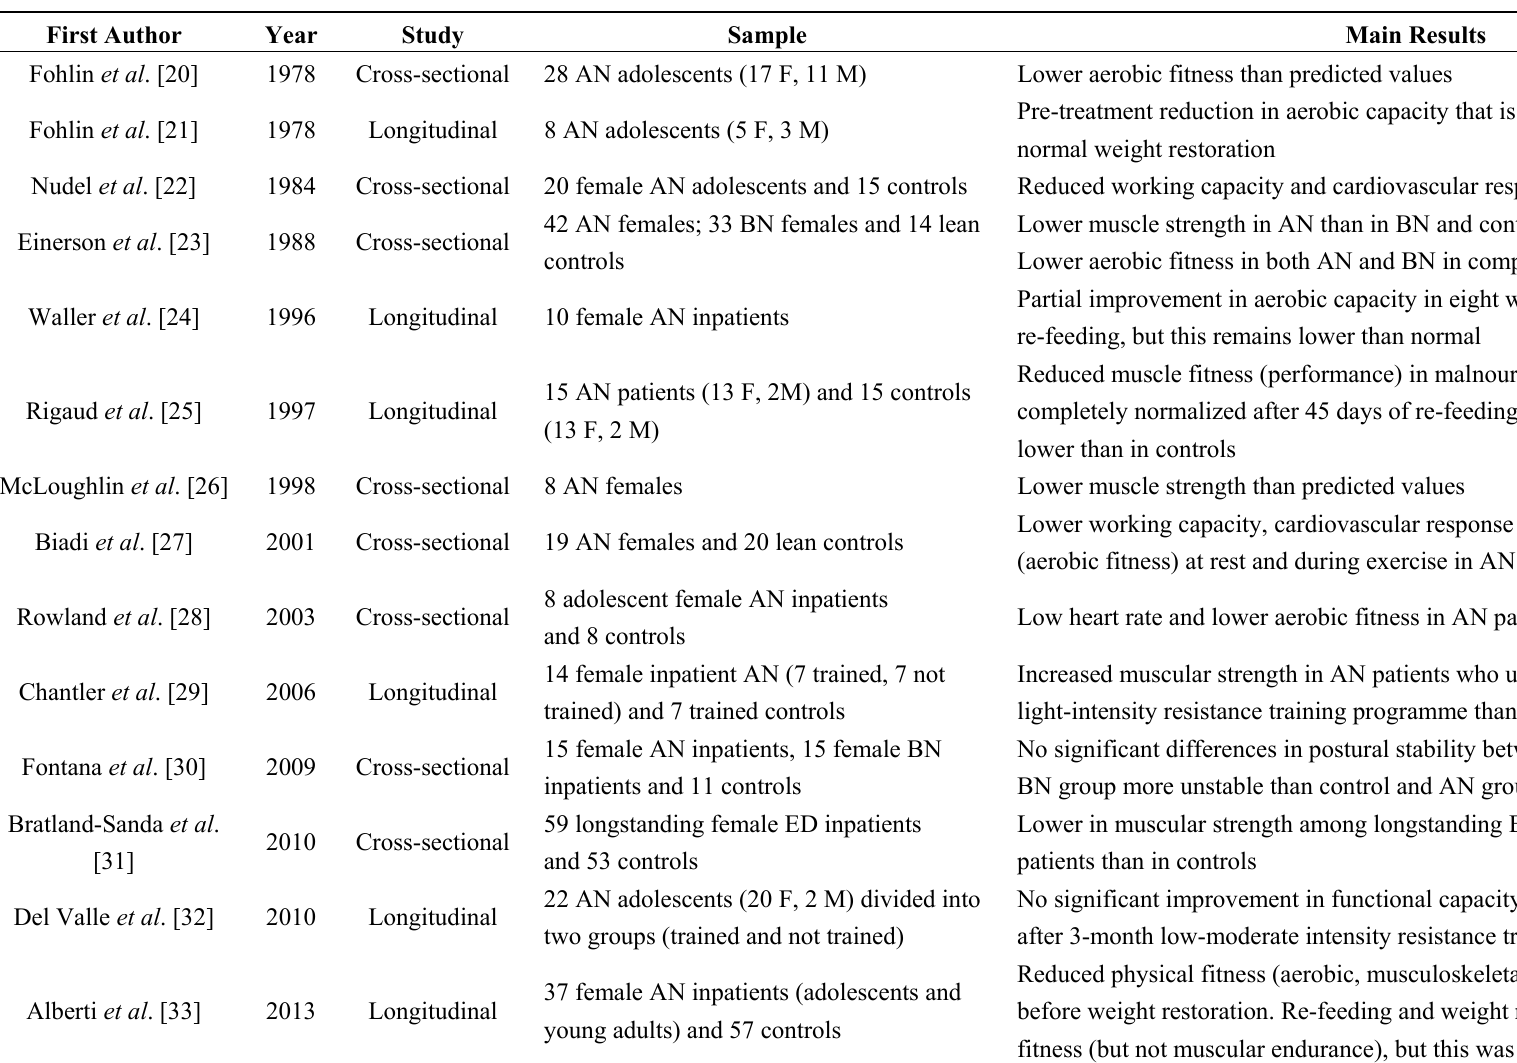
Table 1. Studies assessing physical fitness in eating